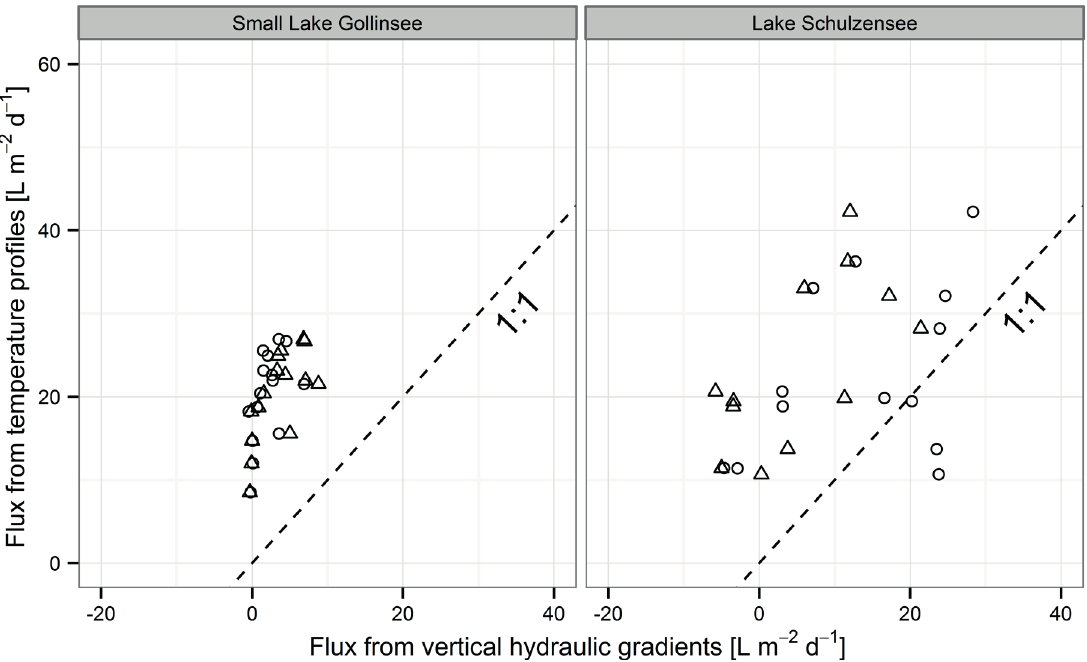
Fig. 3 Fluxes based on VHGs plotted versus fluxes obtained by using heat as a tracer. Plotted with circles: VHGs averaged during the week where temperature profiles were measured, triangles indicate fluxes from hydraulic heads averaged over the study period. The dashed line indicates a perfect agreement. The correlation coefficient is for Small Lake Gollinsee r = 0.54 (week) and r = 0.67 (year); for Lake Schulzensee r = 0.41 (week) and r = 0.67